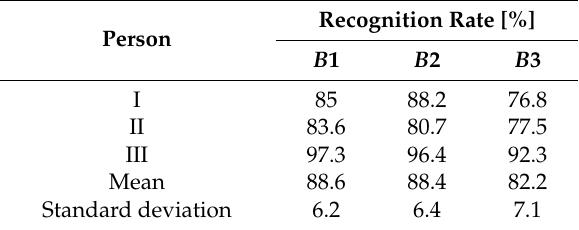
Table 6. Recognition rates of the method using the acronym dictionary. The results were obtained by leave-one-person-out tests, i.e., with T \ T p as the training set and A p as the testing set for person p . Recognition Rate [%] Person B 1 B 2 B 3 I 85 88.2